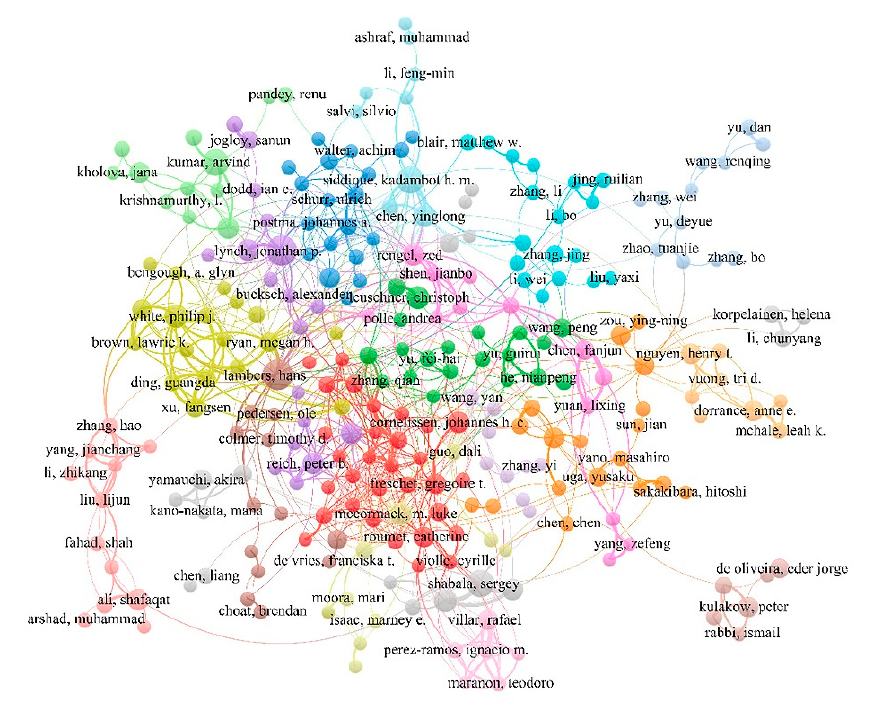
Figure 4 . The network map of co-authorship analysis of authors between 2000 and 2021. The size of nodes indicates the number of published articles, the connection thickness between nodes indicates the degree of cooperation between authors and the color of different nodes indicates different clustering results .